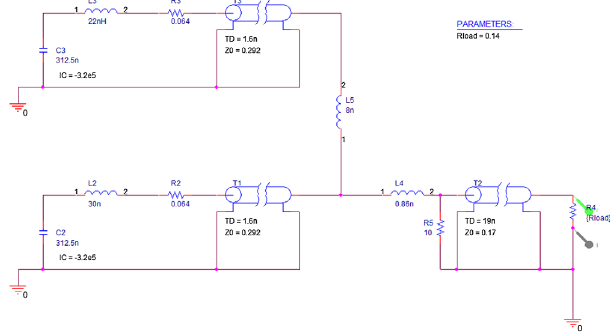
FIG. 5. The circuit model of a hybrid mode LTD stage.